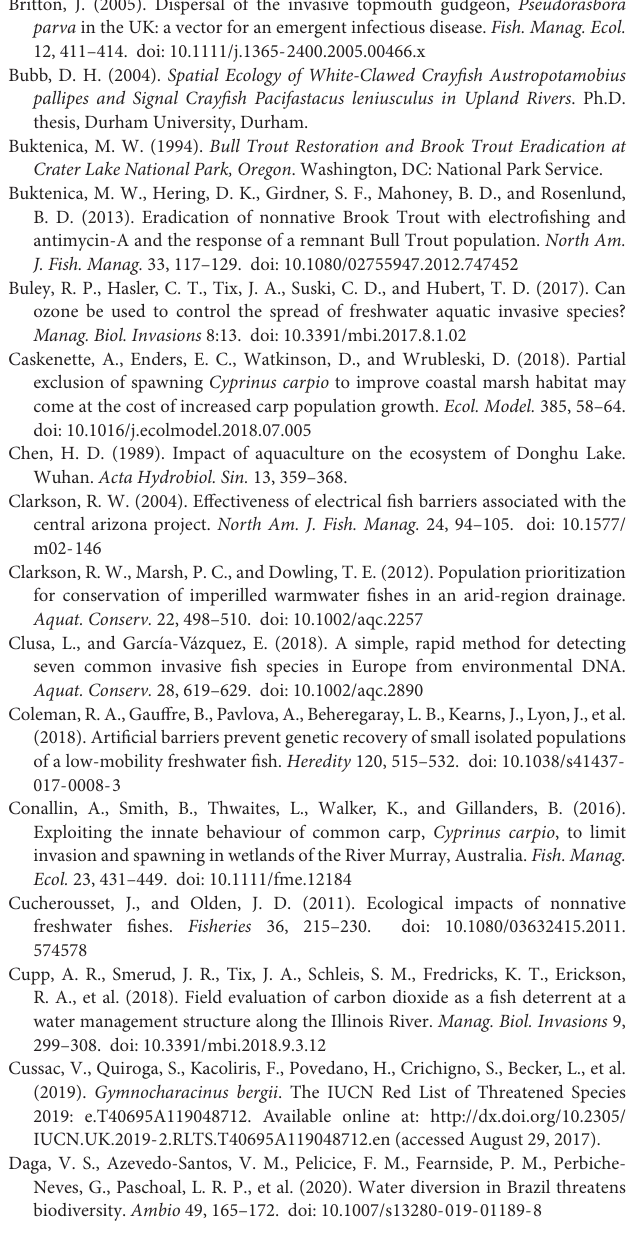
Supplementary Figure 1 | An abstraction weir (A) used to prevent reinvasion of smallmouth bass (B) following eradication using piscicide. Supplementary Figure 2 | Iguaçu Falls (A) , a natural barrier to Brazilian tiger fish ( S. brasiliensis ) (B) , a top predator in Neotropical rivers. Supplementary Figure 3 | Barrier effect of a 1 m high obstacle (waterfall) on the upstream movement of non-native signal crayfish Pacifastacus leniusculus in the River Wharfe, northern England (based on Bubb, 2004). Supplementary Figure 4 | (A) Waterfall augmented with a weir and culvert on the Swin Burn, New Zealand to protect Galaxias anomalus from brown trout (Photo credit: D. Jack), (B) A 30 cm brown trout captured immediately downstream from the barrier on the Swin Burn with six juvenile G. anomalus in its stomach (Photo credit: D.